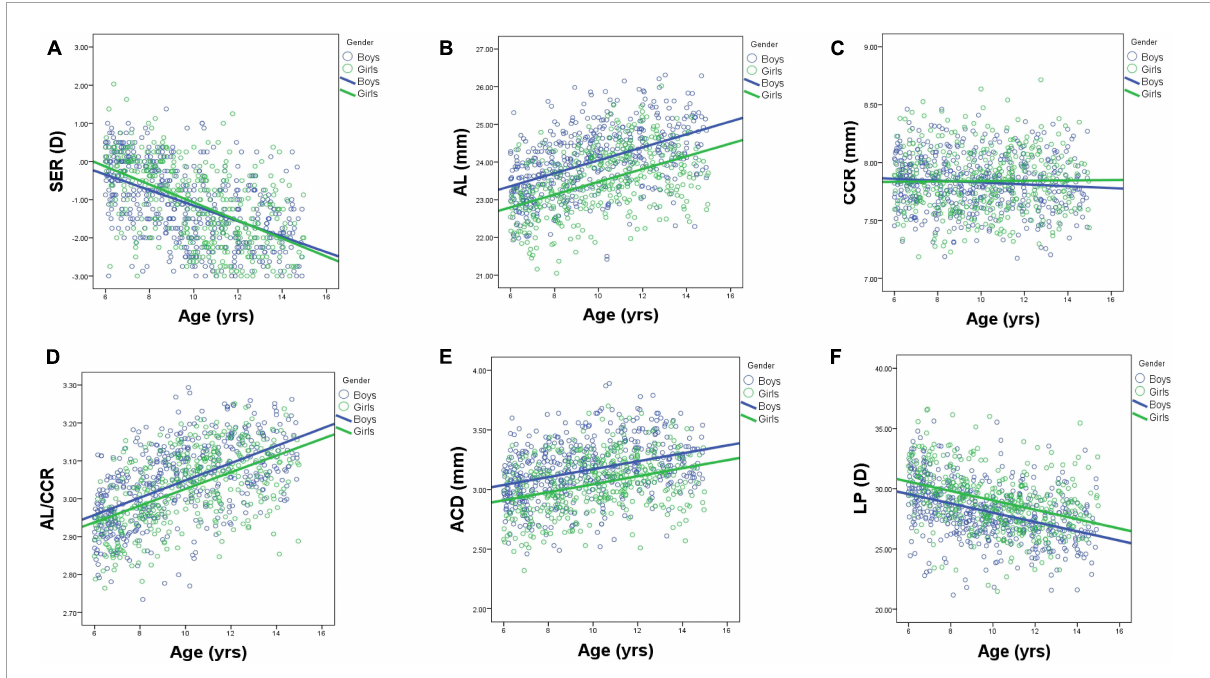
FIGURE4 Scatterplots showing individual data for ocular parameters: SER (A) , AL (B) , CCR (C) , LPAL/CCR (D) , ACD (E) , and LP (F) by age and gender. AL, axial length; ACD, anterior chamber depth; CCR, corneal curvature radius; LP, lens